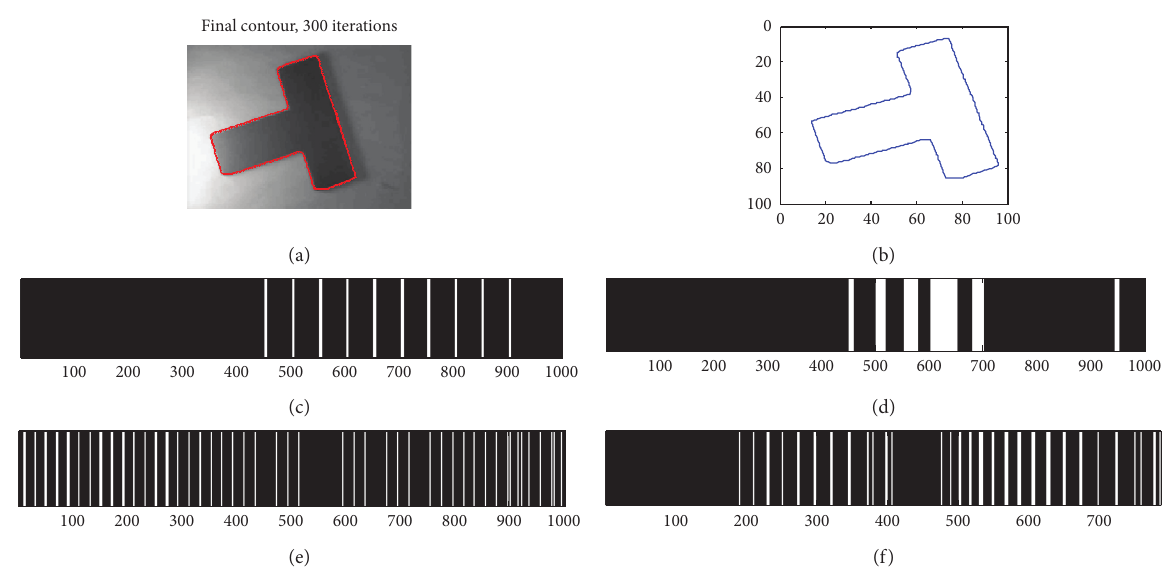
Figure 2: Result of global image pixels and image contour feature coding chain. (a) Row set LCV model image segmentation result. (b) Image contour. (c) Coding chain result of the global pixels in row direction. (d) Coding result of the contour features in row direction. (e) Coding result of the contour features in column direction. (f) Coding result of the contour features in oblique